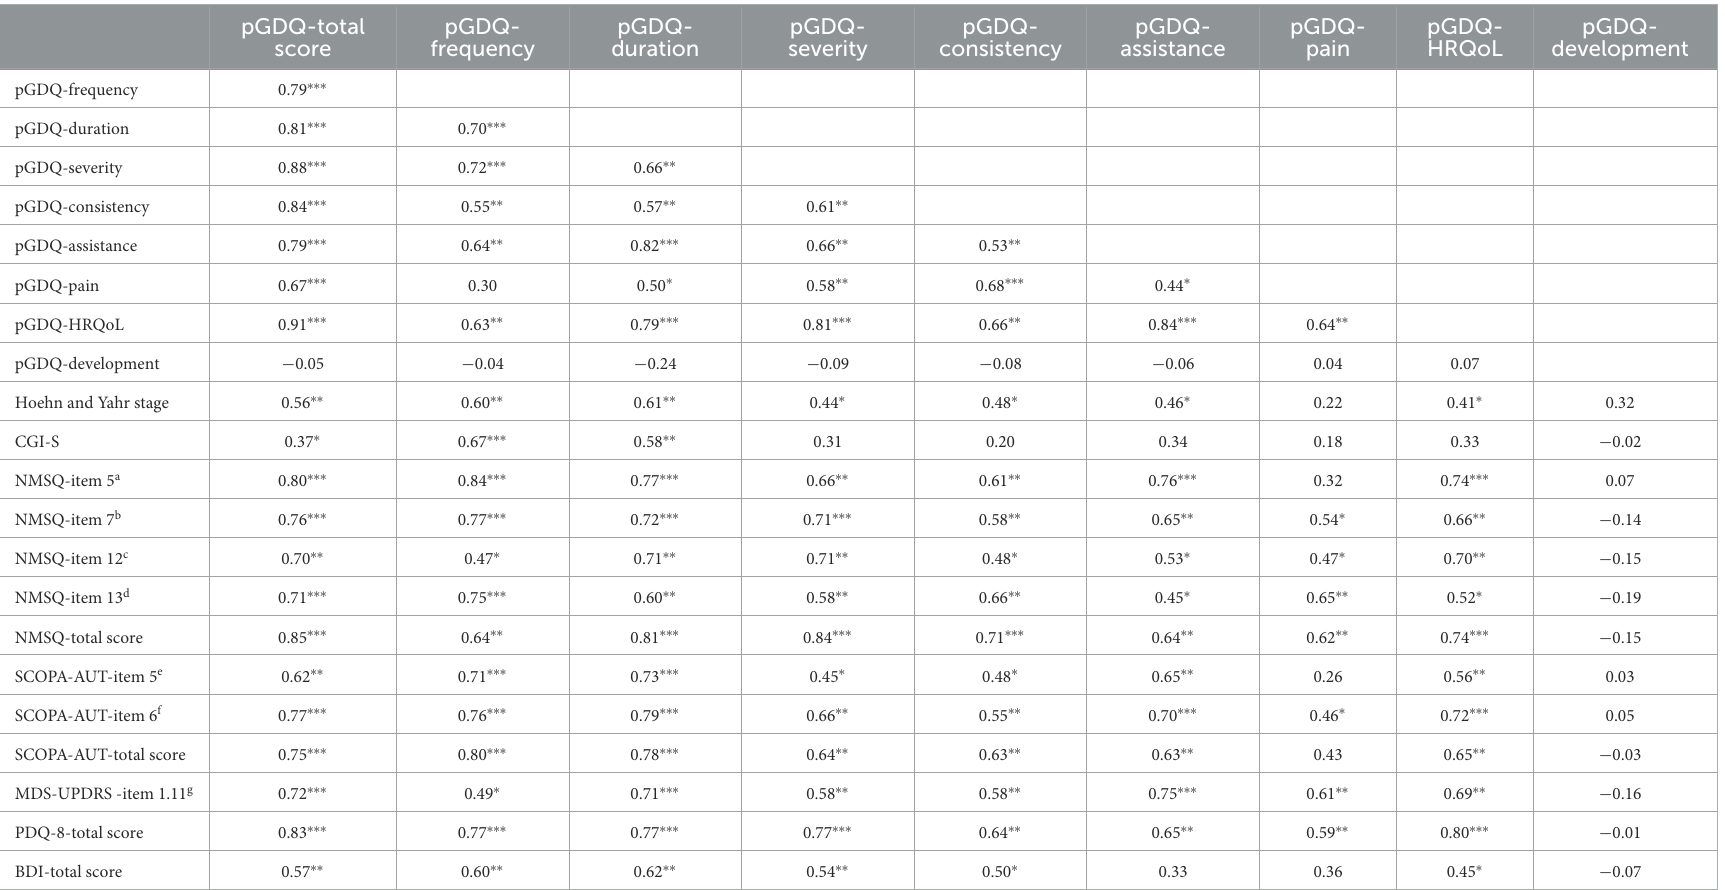
TABLE 3 Intercorrelation and construct validity of pGDQ domains in patients with Parkinson’s